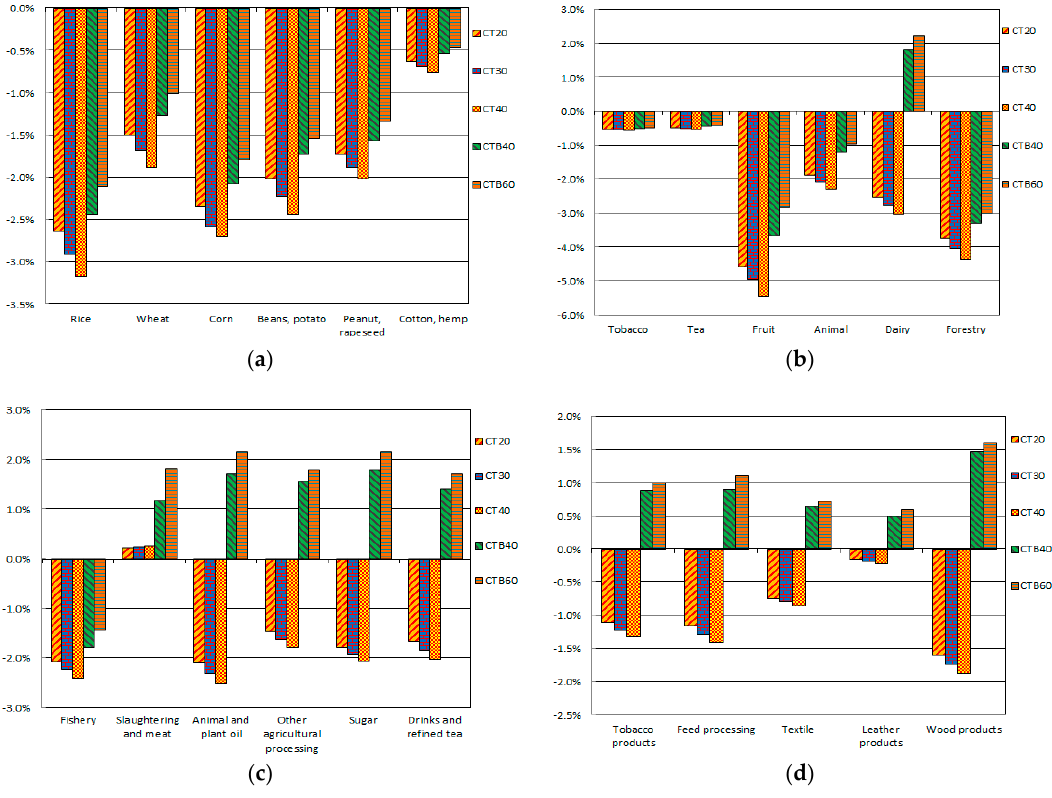
Figure 4. The change in the return on capital in agriculture-related sectors under different scenarios in 2050 (compared with the BAU scenario). Table 5. The changes in the return on capital in agriculture-related sectors under different scenarios compared with the BAU scenario (%) (from rice to tea).